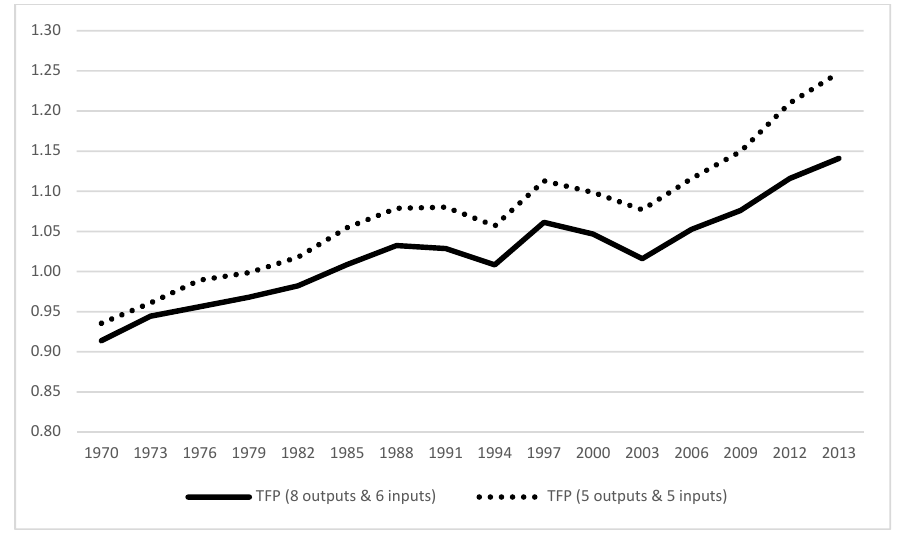
Figure A1. Comparison of TFP with a reduced number of inputs and outputs with the original specification. Table A1. Countries and regional groupings included in the TFP Analysis.